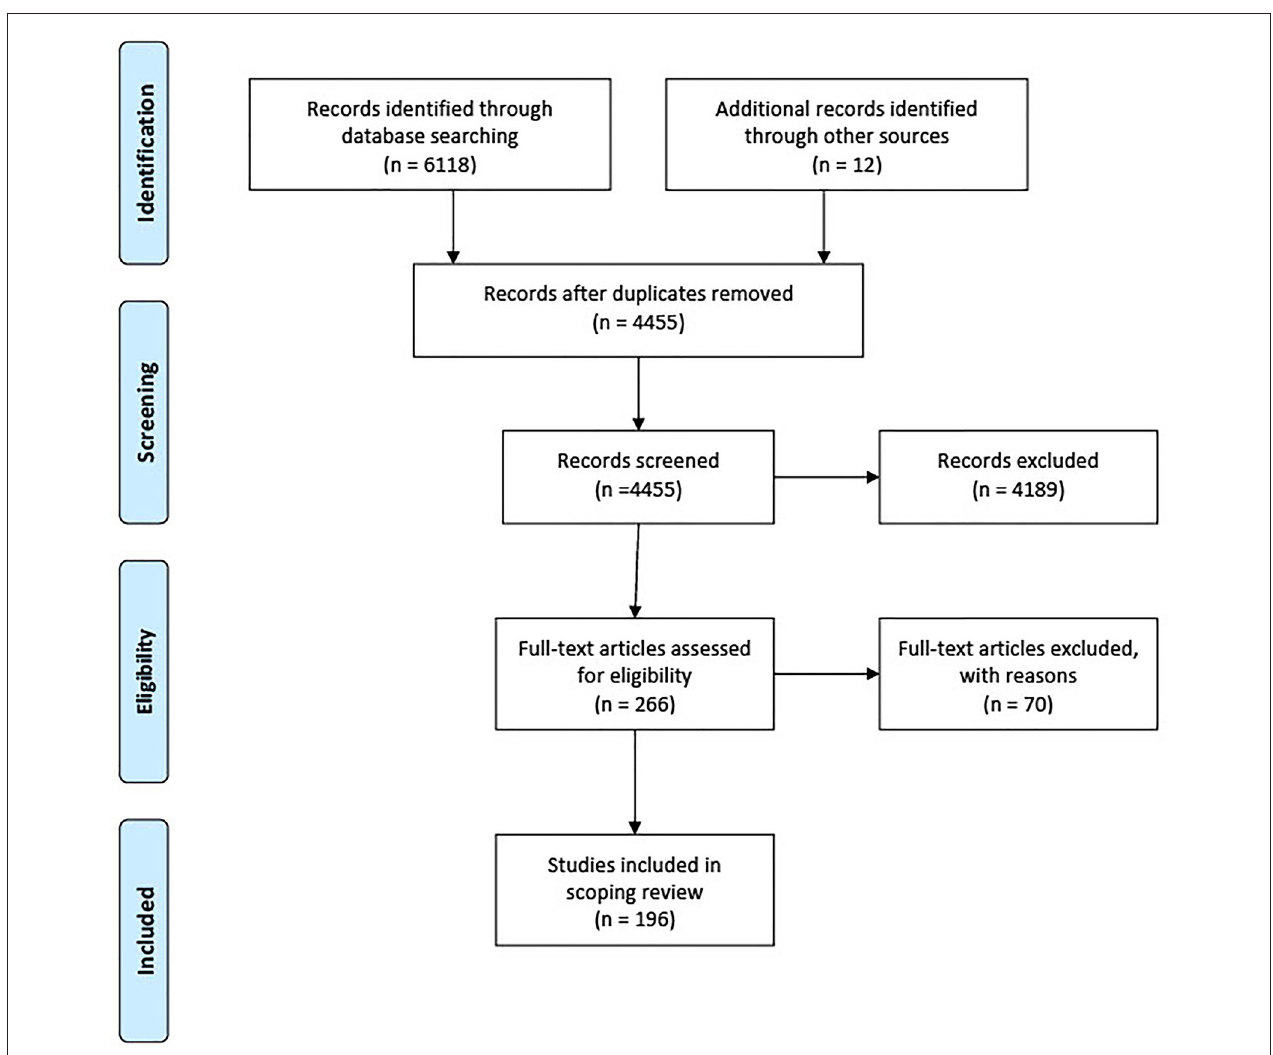
FIGURE 1 | PRISMA flow chart of study selection process for scoping review. Studies published between January 1st, 2000, to July 21st, 2020, were